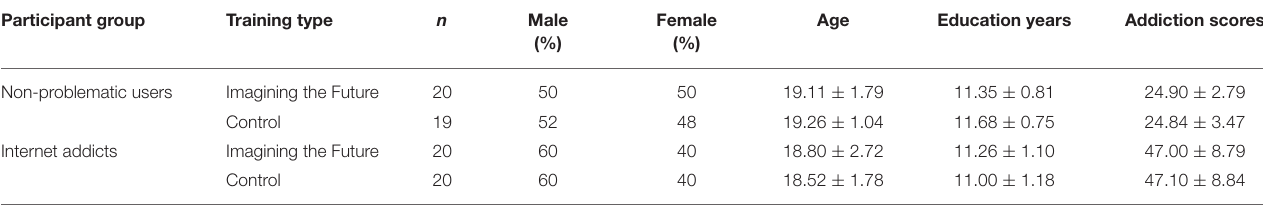
TABLE 1 | The characteristics of participants ( M ± SD